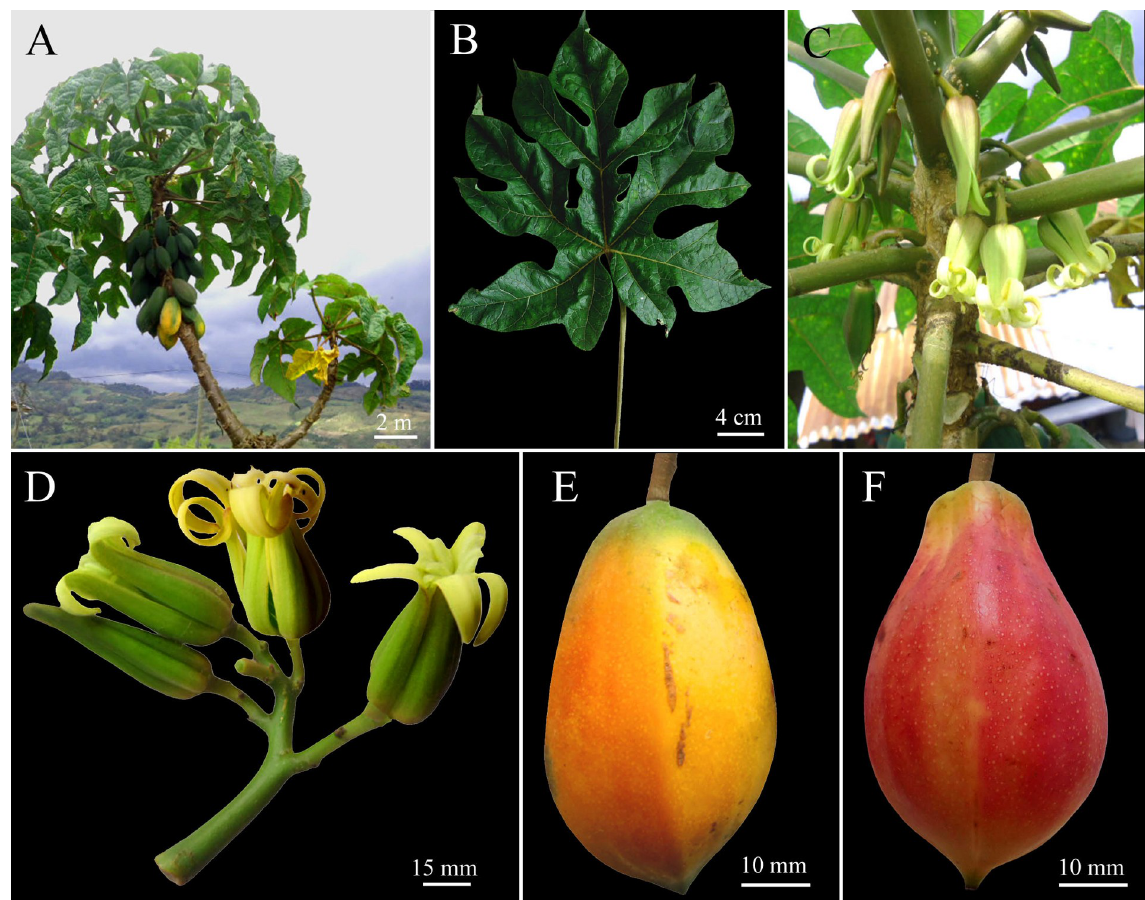
Fig 3. Morphology of Vasconcellea badilloi sp. nov. (CHAX224). A, Habit. B, Palmately compound leaf. C, Axillary flowers. D, Female inflorescence. E, F, Mature